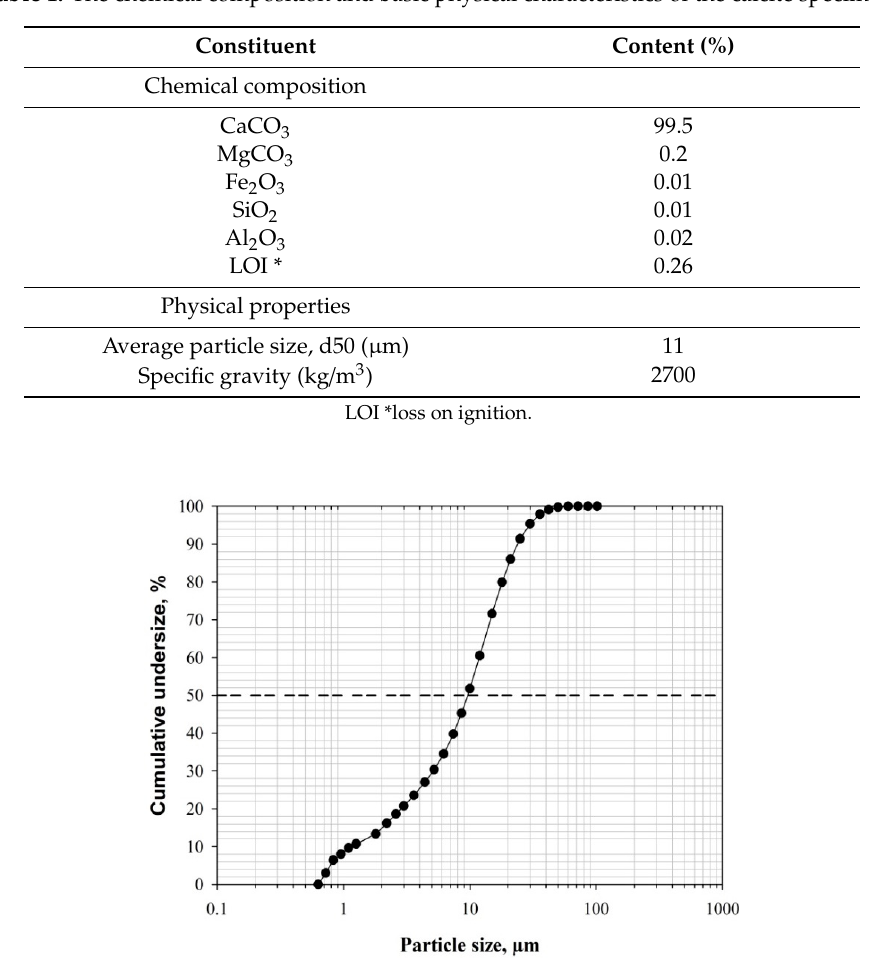
Figure 1. The particle size distribution of the feed material for grinding. Minerals 2020 , 10 , x FOR PEER REVIEW Table 1. The chemical composition and basic physical characteristics of the calcite specimen.